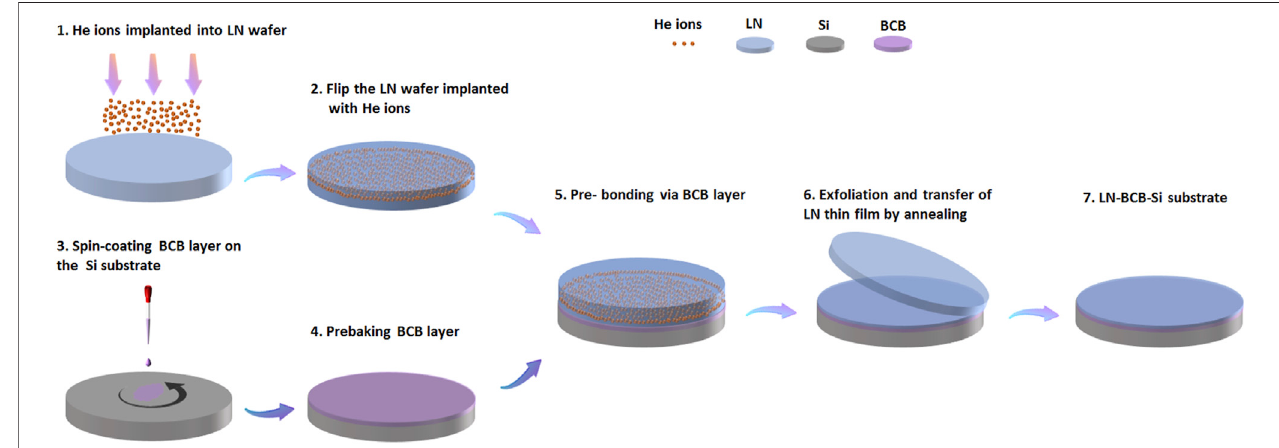
FIGURE 1 | The schematic drawing of POS substrate preparation process by smart-cut